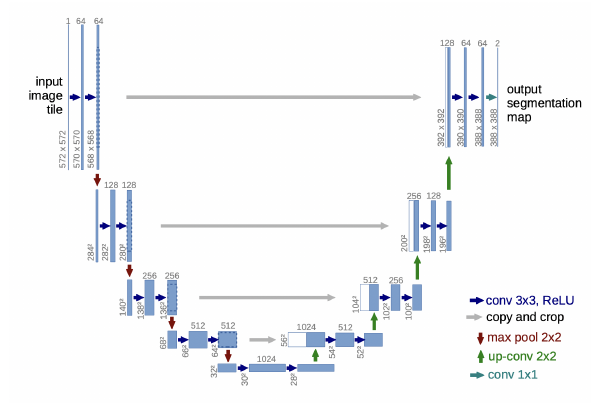
Figure 1. U-Net architecture from (Ronneberger et al., 2015) Both encoder and decoder paths are composed of blocks with two 3 × 3 convolutions, each followed by a rectified linear unit (ReLU) activation function. 2 × 2 max-pooling layers perform the downsampling operations with stride 2. The number of fea- ture maps doubles after each downsampling step. Each block in the decoder path involves a transposed convolution, whose results are concatenated with the corresponding feature maps computed in the encoder path. The encoder and decoder follow the same pattern of two 3 × 3 convolutions followed by ReLU activation functions.